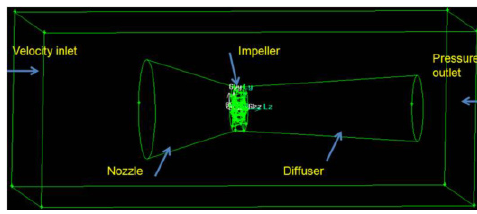
Figure 3. Boundary conditions stetting in Gambit.